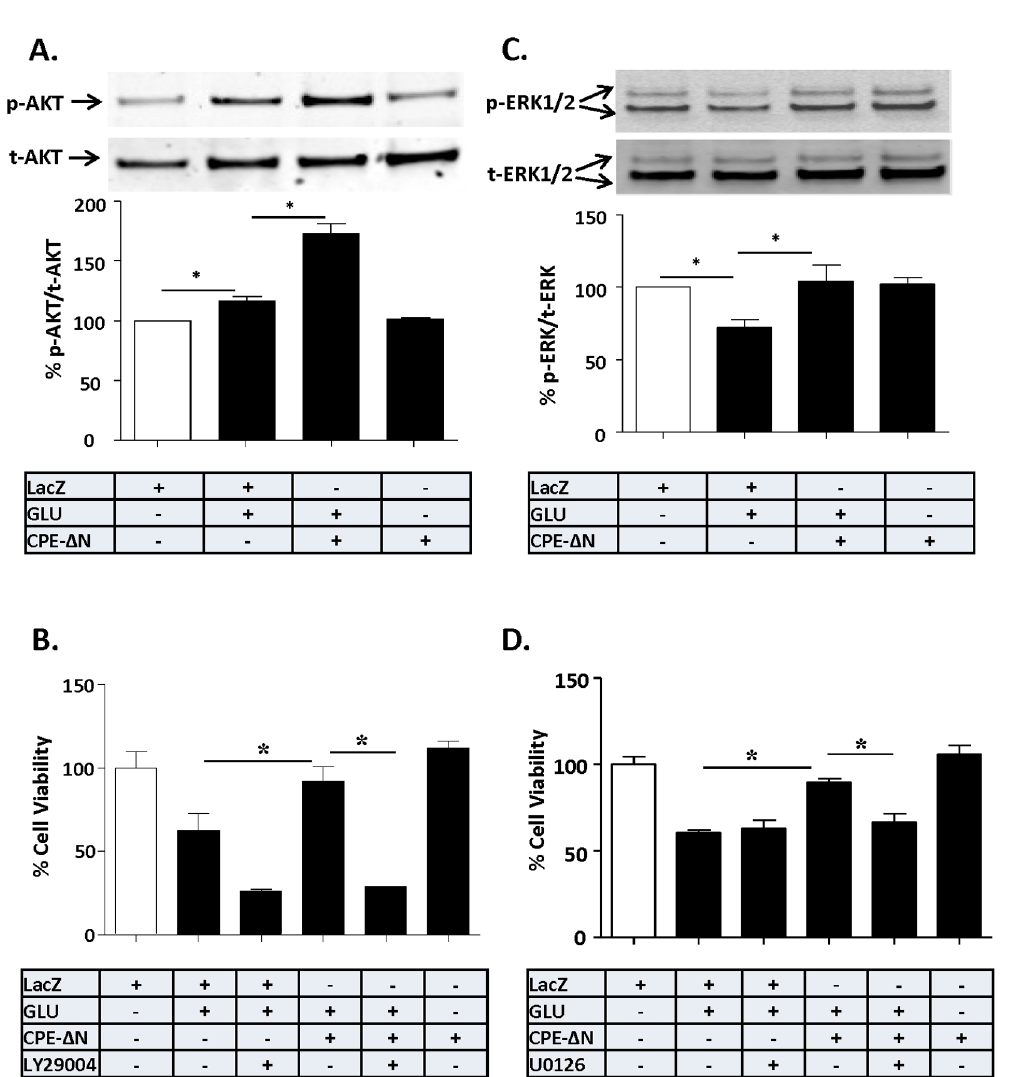
Figure 5. Neuroprotection by CPE- D N involves AKT and ERK signaling pathways. In A–D, rat primary cortical neurons were transduced with CPE- D N or LacZ vectors and subsequently challenged with or without glutamate for 24 h. A. Top panel: Western blot analysis of p-AKT protein in cortical neurons. Actin was also analyzed and served as an internal control for protein load. Bottom panel: Bar graphs showing the quantification of p-AKT normalized to t- AKT and expressed as a % compared to vehicle treated control cells. Note that CPE- D N significantly increased the level of p-AKT after the glutamate treatment in primary cultured cortical neurons. At least three independent experiments were done. Data shown represent all the experiments combined. B. Bar graphs showing WSTactivity, indicative of cell viability, of cortical neurons treated with and without glutamate in the continued presence or absence AKT inhibitor, LY294002. Note the neuroprotective effect of CPE- D N was completely blocked by LY294002, suggesting the AKTsignaling pathway is involved in the neuroprotective effect of CPE- D N in primary cortical neurons. Two independent experiments were done. Data shown represent one experiment. C. Top panel: Western blot analysis of p-ERK in primary cortical neurons. Actin was also analyzed and served as an internal control for protein load; bottom panel: Bar graphs showing the quantification of p-ERK normalized to t-ERK and expressed as a % compared to vehicle treated control cells. Note that CPE- D N significantly inhibited the glutamate-induced decrease in p-ERK in primary cortical neurons. At least three independent experiments were done. Data shown represent all the experiments combined. D. Bar graphs showing WSTactivity, indicative of cell viability of cortical neurons treated with and without glutamate in the continued presence or absence of the ERK inhibitor, U0126. Note the neuroprotective effect of CPE- D N was partially blocked by U0126 suggesting the involvement of ERK signaling pathway in the cortical neurons. Two independent experiments were done. Data shown represent one experiment. n 5 4/ group (A); 5/group (B); 4/group (C); 5/group (D). Values are mean ¡ SEM, one-way ANOVA followed by Tukey test, *p , 0.05.